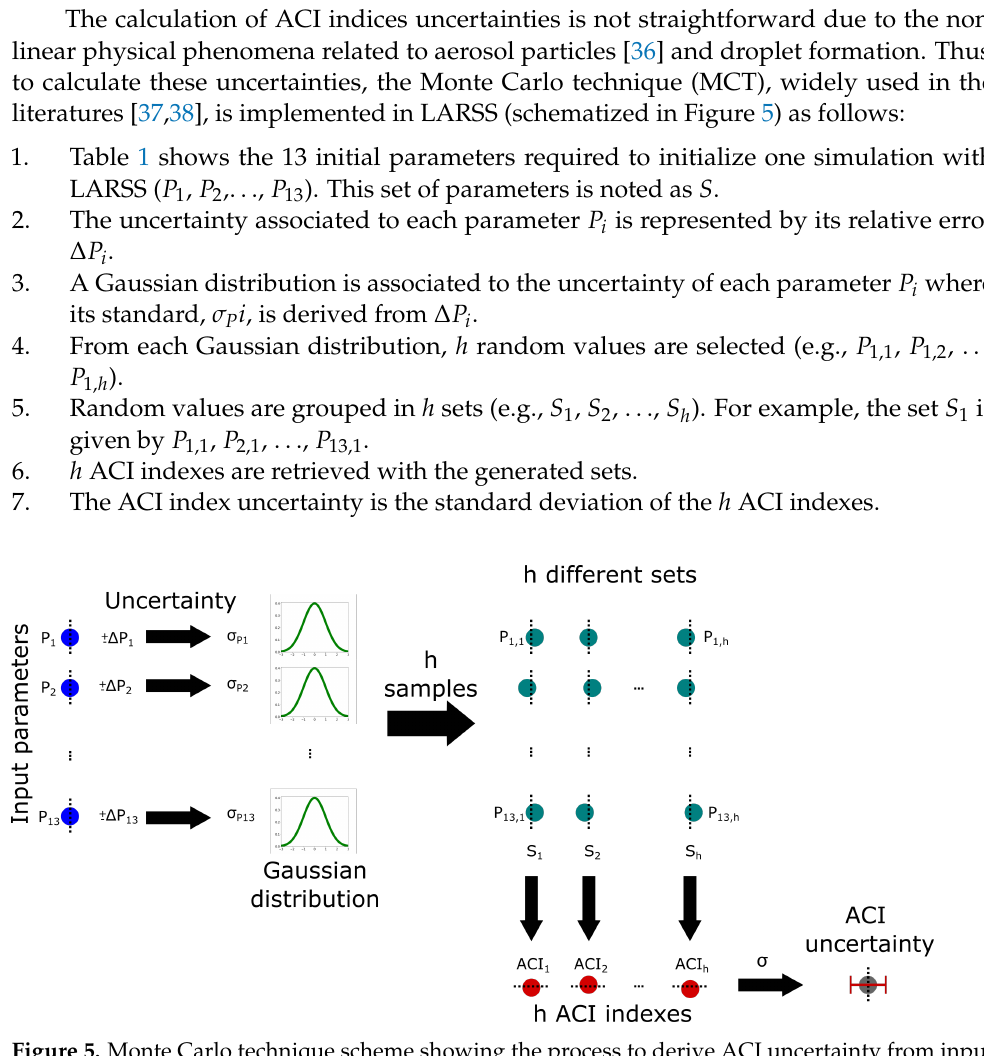
Figure 5. Monte Carlo technique scheme showing the process to derive ACI uncertainty from input parameter uncertainties ( P i ± ∆ P i )